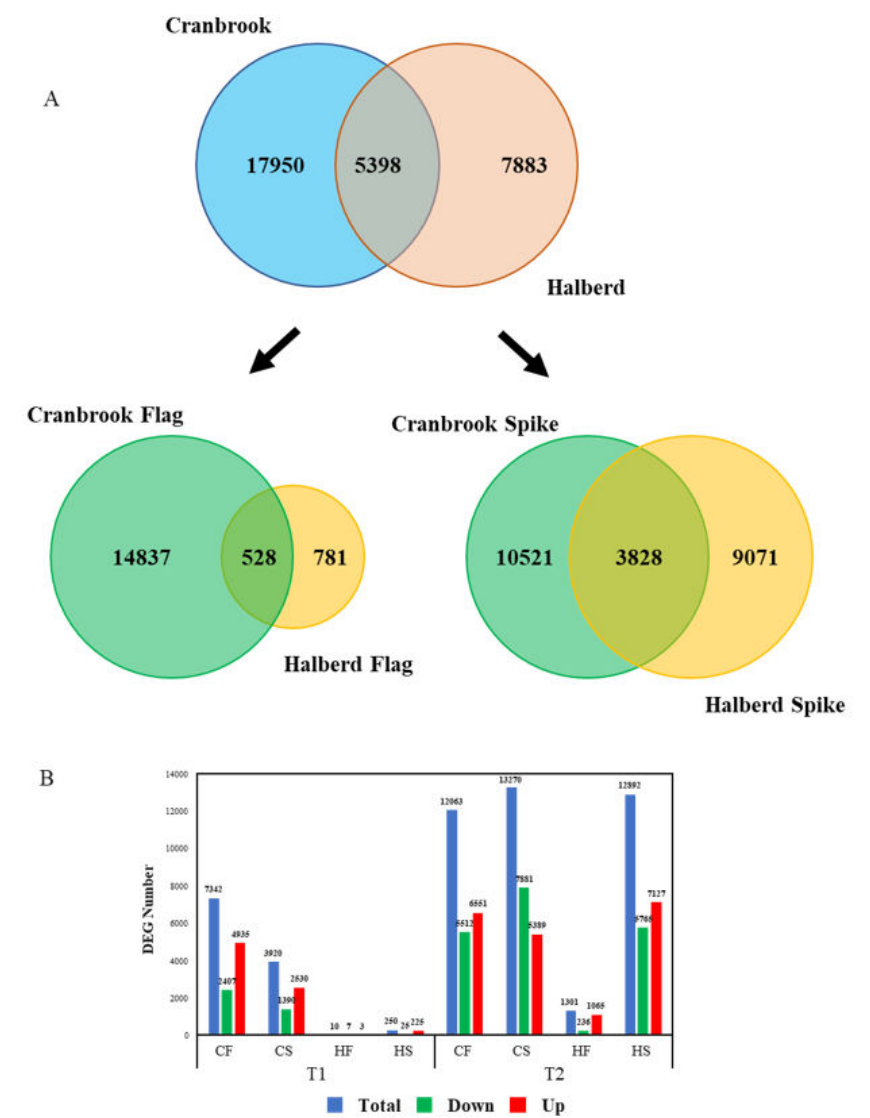
Figure 4. ( A ) Quantitative analysis of the transcriptome data using Venn diagrams. The diagrams represent the comparison of the total DEG numbers for Cranbrook and Halberd flag leaves and spikes (top) and the flag leaf and spike DEG numbers for each separately (bottom graph). ( B ) Break-up of the DEG numbers in total, up-regulated and down-regulated gene numbers at each time point for Cranbrook (C) and Halberd (H) flag leaves (HF, CF) and spikes (HS,